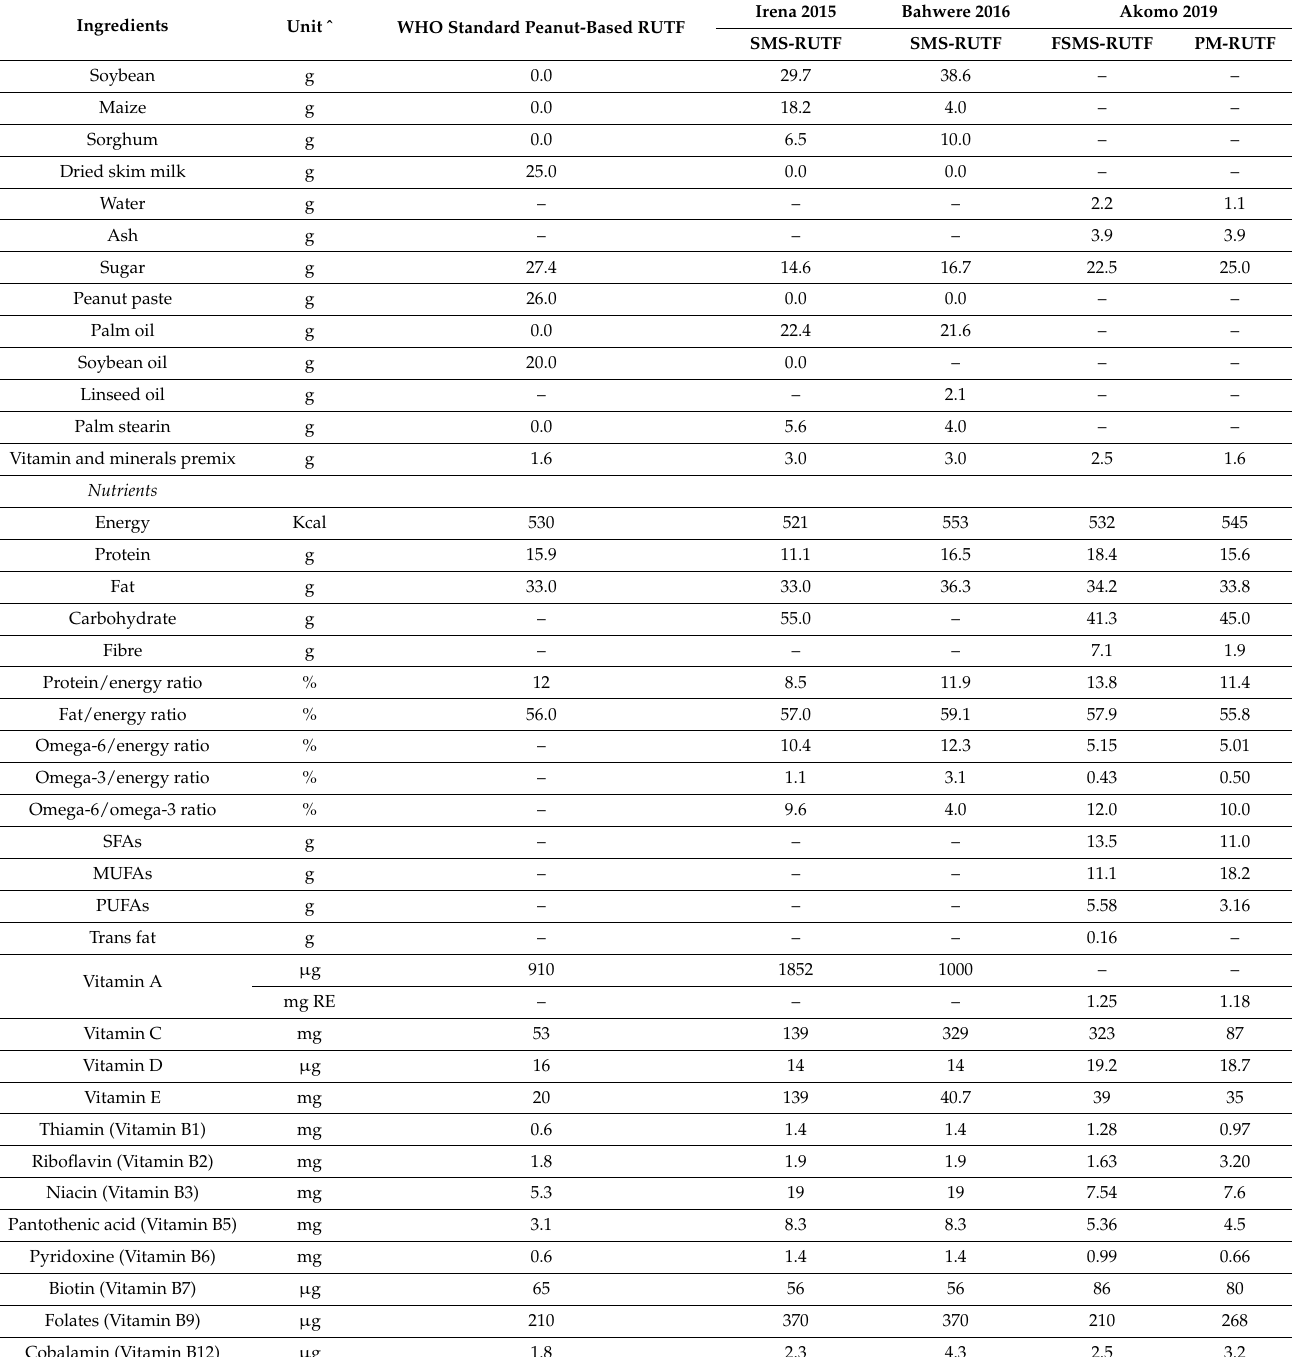
Table 3. Macronutrient and micronutrient composition of RUTF in the included